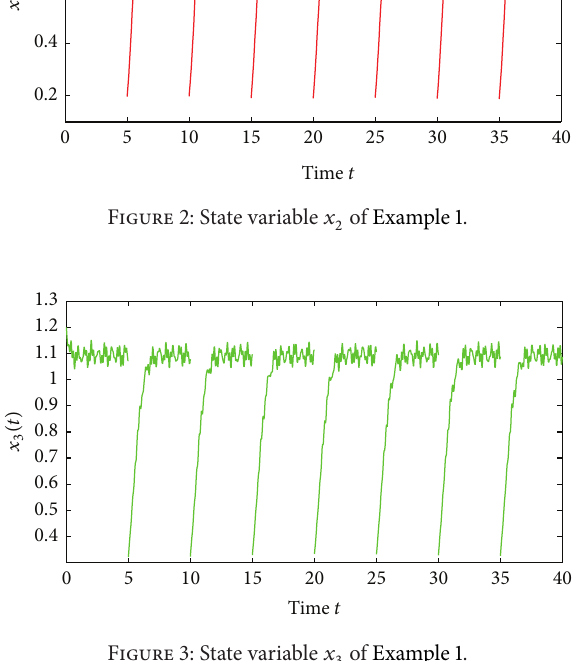
Figure 3: State variable 𝑥 3 of Example 1.